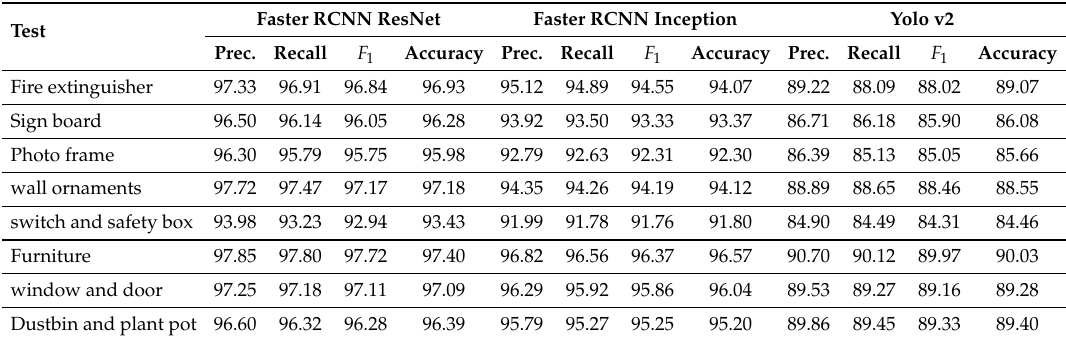
Table 6. Comparison with other object detection